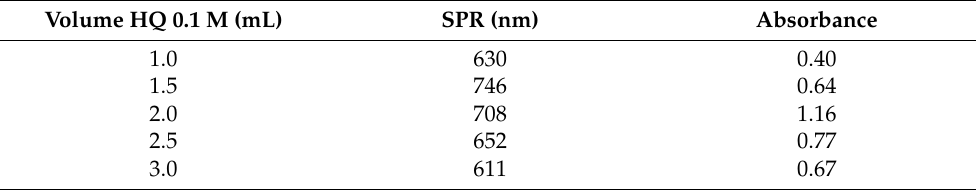
Table 5. The influence of HQ to surface plasmon resonance and intensity